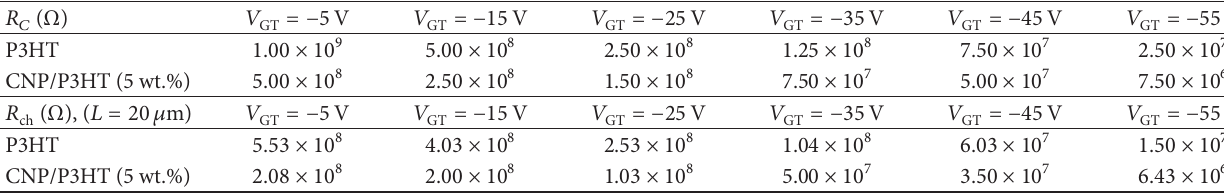
Table 2: Contact resistance and channel resistance